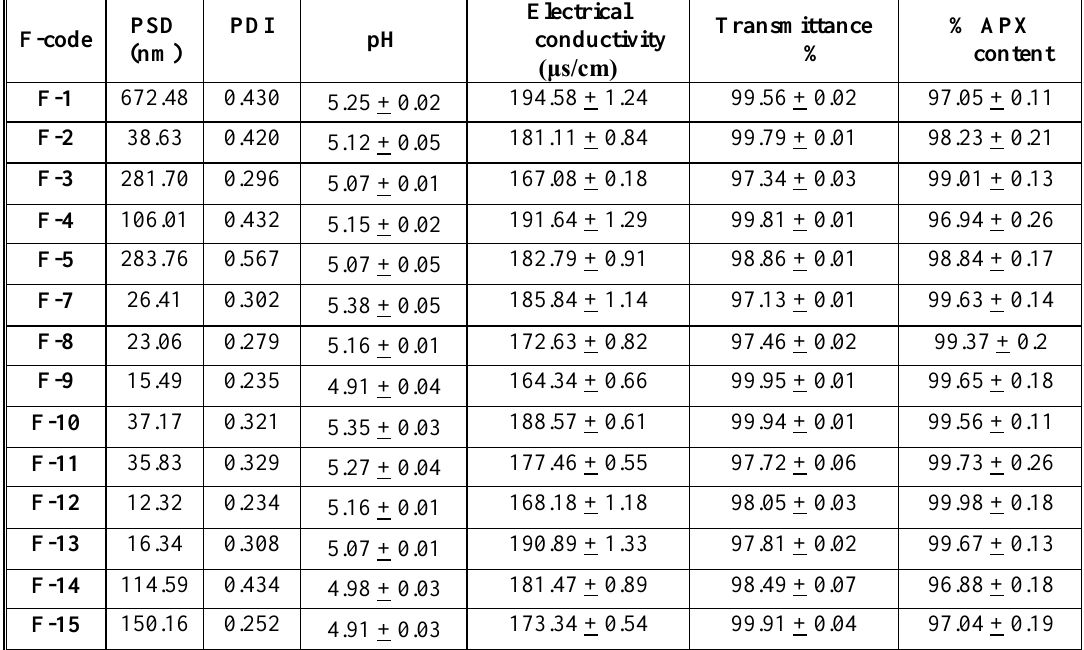
Table 2. Results of PSD, PDI, pH, electrical conductivity, T%, APX content%, for the prepared APX-NE formulations, (mean ± SD, n =